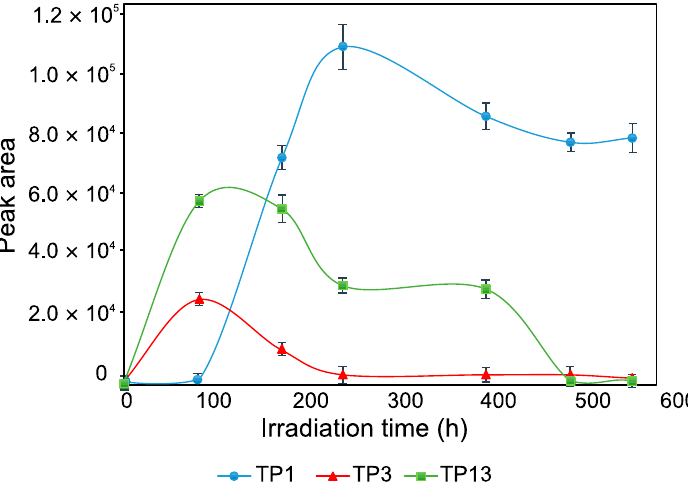
Figure 3. Time evolution of peak areas of TP1 ( m/z 261), TP3 ( m/z 357) and TP13 ( m/z 355).